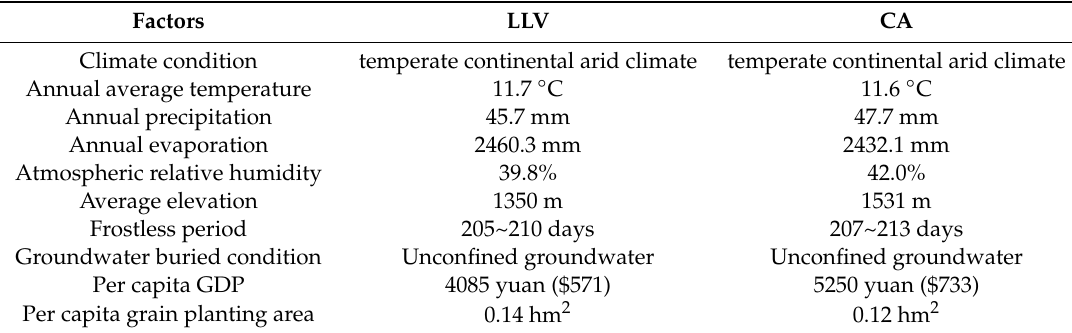
Table 1. Comparison of the climate factors, hydrogeology conditions and economic